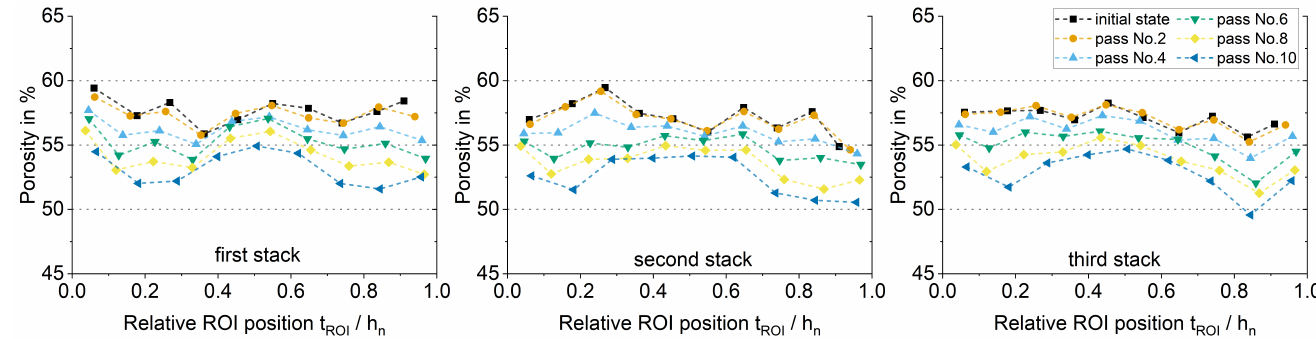
Figure 16. Series I: 5-0.15-10 ( l d / h m ≈ 0.5 − 0.75): Porosity change over relative sample depth (0=upper surface; 0.5= mid-section of sample; 1=lower surface) due to rolling for first, second and third